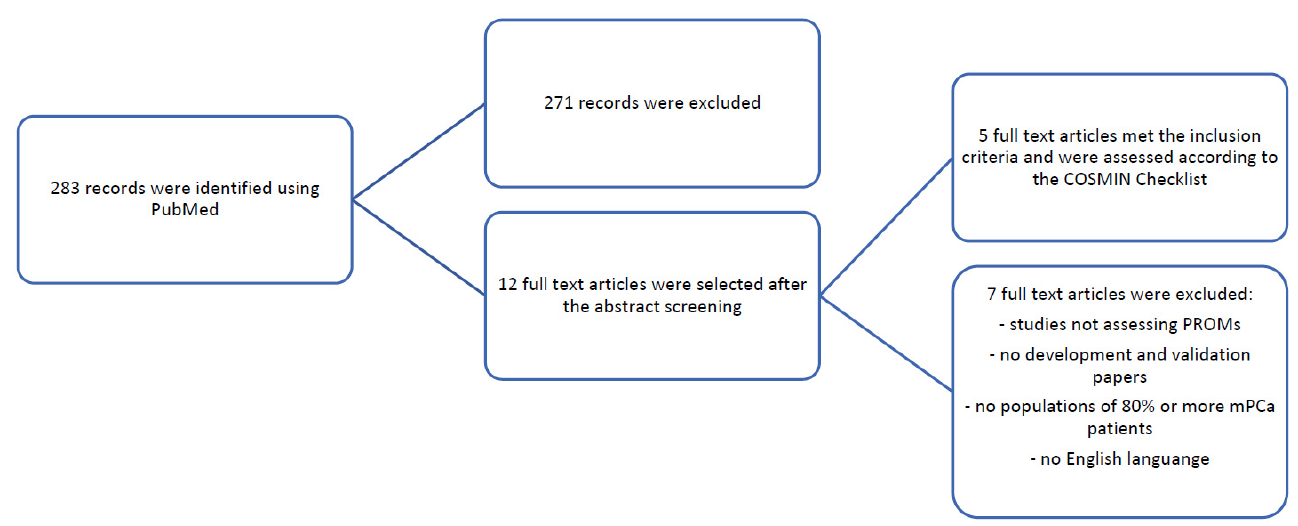
Figure 1. Flow diagram for study selection.